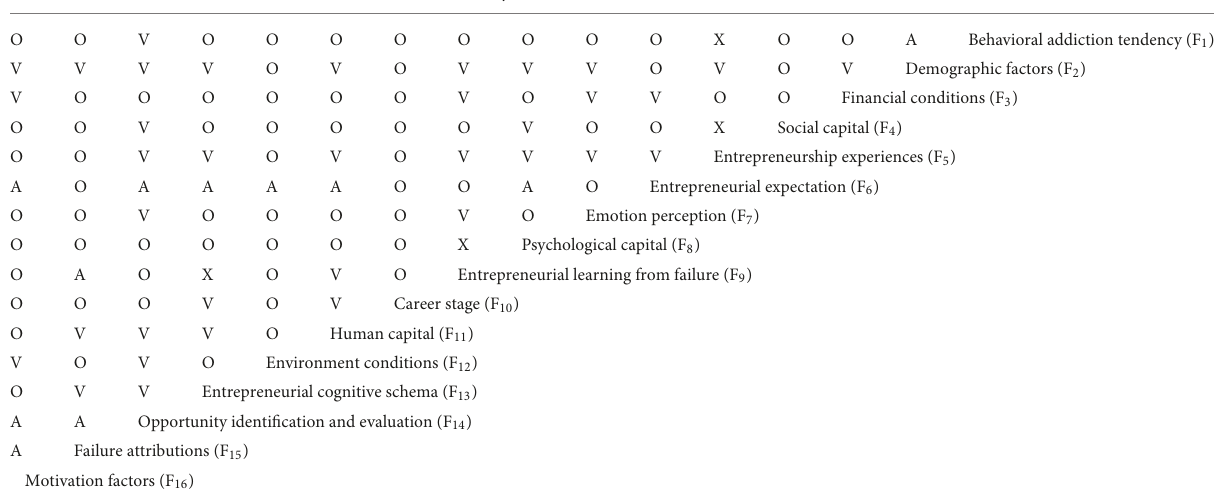
TABLE 3 Pair-wise comparison of 16